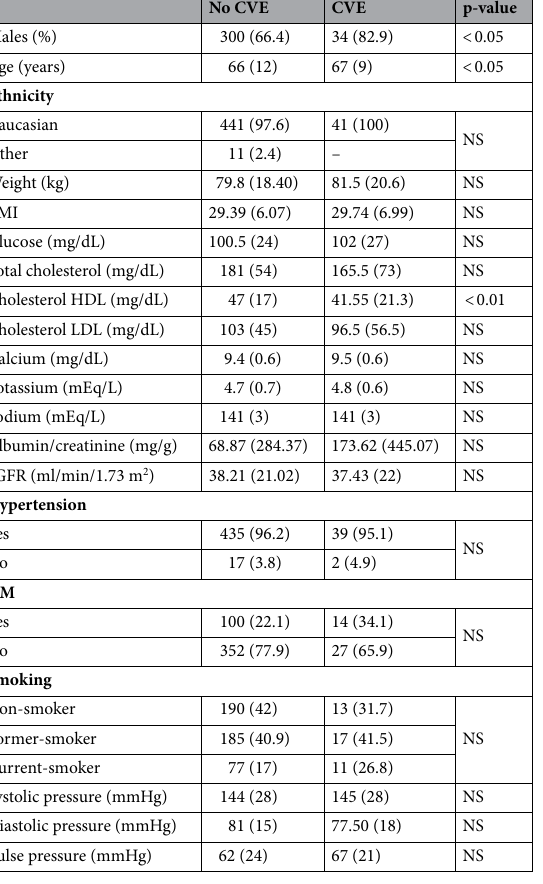
Table 2. Characteristics of individuals with and without cardiovascular events registered during the follow-up in the whole population of study. BMI body mass index, eGFR estimated glomerular filtration rate, DM diabetes mellitus, NS not significant.